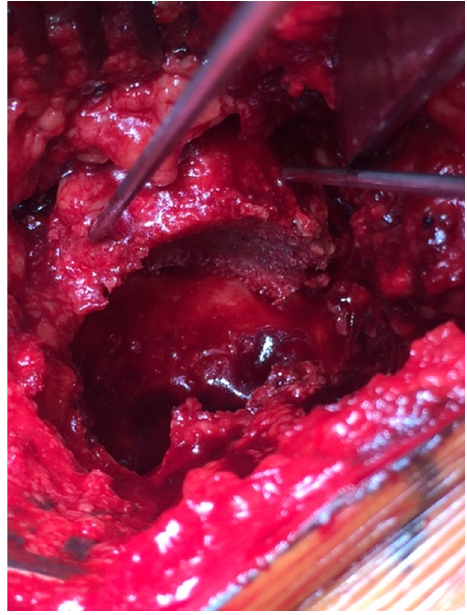
Figure 7. After cavity reaming with the superior graft fi xed by 2 temporary